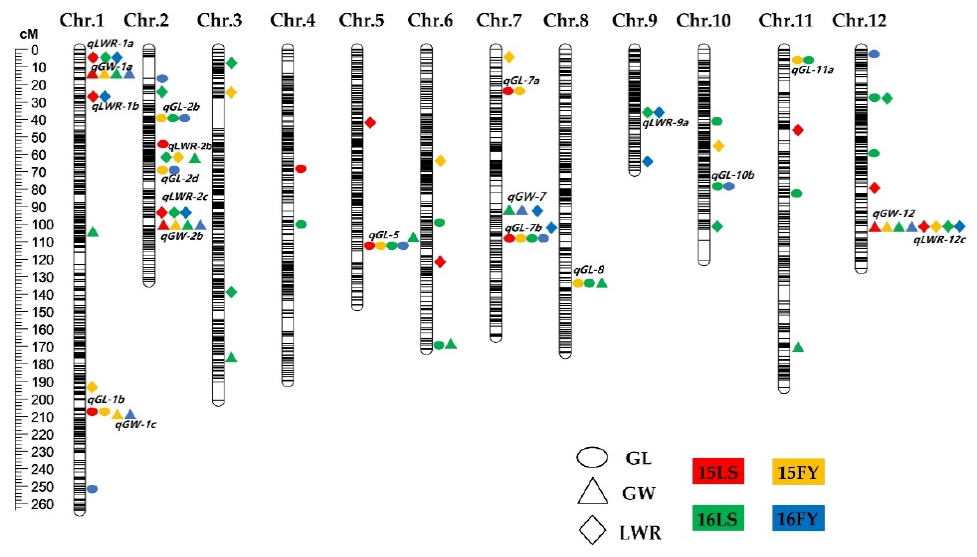
Figure 2. The positions of detected QTLs for grain shape traits in RISLs. Nine QTLs ( qGL-1b , qGL-2b , qGL-2d , qGL-5 , qGL-7a , qGL-7b , qGL-8 , qGL-10b , and qGL- 11a ) associated with grain length were detected on chromosomes 1, 2, 5, 7, 8, 10, and 11, respectively. Each of them explained a phenotypic variance ranging from 2.25% to 10.04%. The beneficial alleles of qGL-1b , qGL-2b , and qGL-2d were from R8006, while the other six loci were inherited from Nei2B. Moreover, both qGL-5 and qGL-7b were detected in all four environments with the PVE from 5.57% to 10.04% and from 3.32% to 4.33%, respectively. For grain width, five QTLs ( qGW-1a , qGW-1c , qGW-2b , qGW-7 , and qGW-12 ) were mapped on chromosomes 1, 2, 7, and 12 with the PVE ranging from 2.53% to 11.93%. With the additive effects from R8006, the stable qGW-2b represented 4.15%, 4.26%, 4.60%, and 6.58% of the phenotypic variance in 15LS, 15FY, 16LS, and 16FY, respectively. With positive alleles from Nei2B, qGW-1a and qGW-12 were also detected across four environments, explaining 2.98% to 4.74% and 3.68% to 11.93% of phenotypic variance, respectively. How- ever, qGW-1c and q GW-7 were only detected in two environments and their positive alleles were conferred from R8006. Six QTLs ( qLWR-1a , qLWR-1b , qLWR-2b , qLWR-2c , qLWR-9a , and qLWR-12c ) for length- width ratio were mapped on chromosomes 1, 2, 9, and 12 with the PVE ranging from 2.38% to 8.21%. Among them, only the positive allele for qLWR-2c came from Nei2B, which could be tested in 15FY, 16LS and 16FY, expounding 3.06%, 5.19%, and 5.56% phenotypic variance, respectively. Additionally, the R8006 alleles contributed to the other five QTLs, such as qLWR-1a , qLWR-1b , qLWR-2b , qLWR-9a , and qLWR-12c . The qLWR-1a was detected in the same three environments as qLWR-2c . Notably, qLWR-12c was detected across four environments with the PVE from 4.13% to 8.21% and positionally overlapped with qGW-12 . This happened to qGL-1b and qGW-1c as well. Some QTLs formed several clusters: qGL-1b/qGW-1c for grain length and grain width, qGL-2b for grain length, qGL-2d/qLWR-2b for grain length and length-width ratio, qGL-5 for grain length, qGL-6b/qGW-6 for grain length and grain width, qGL-7a for grain length, qGL-7b/qGW-7 , qGL-8 for grain length, qGL-10b for grain length, qGL-11a for grain length, qGL-12b/qLWR-12a for grain length and length-width ratio, qGW-1a/qLWR-1a/qLWR-1b for grain width and length-width ratio, qGW-2b/qLWR-2c for grain width and length-width ratio, qGW-12/qLWR-12c for grain width and length-width ratio, and qLWR-9a for length- width ratio. Compared with the previous study, only qGL-7a , qGL-8 , and qGL-11a were the new QTLs (Table